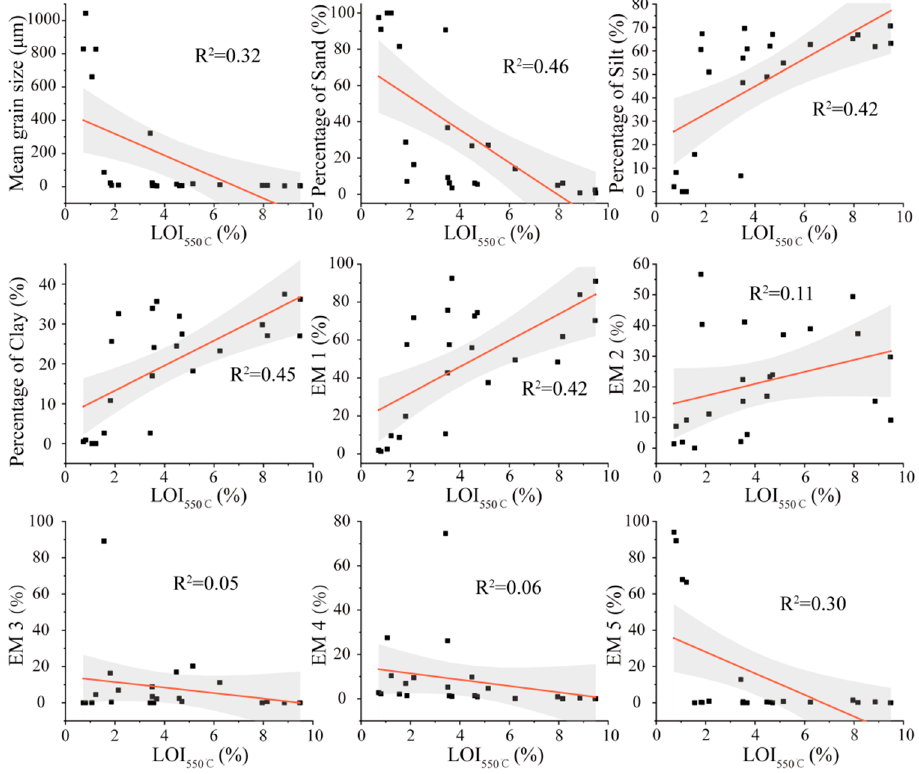
Figure 9. Correlation between organic matter content and grain size along with endmember components of 24 sediment samples in the Lu’erhuan River Sea area of Qinzhou Bay, Guangxi